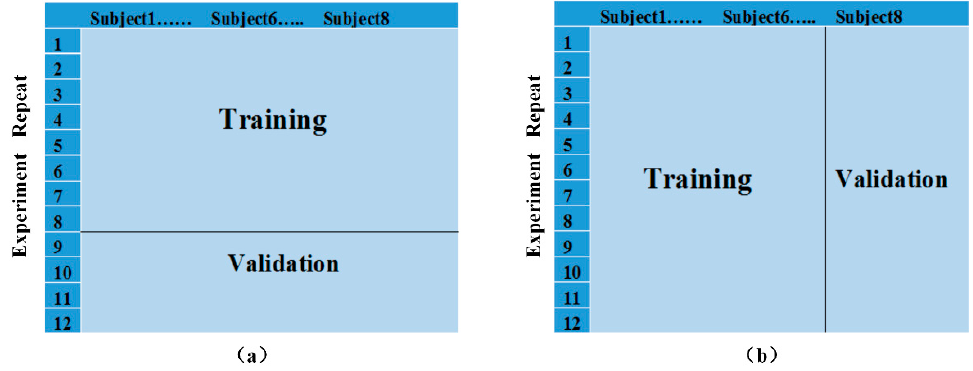
Figure 9. Schematic diagrams of the two selection scenarios. ( a ) The first scenario; ( b ) The second scenario.